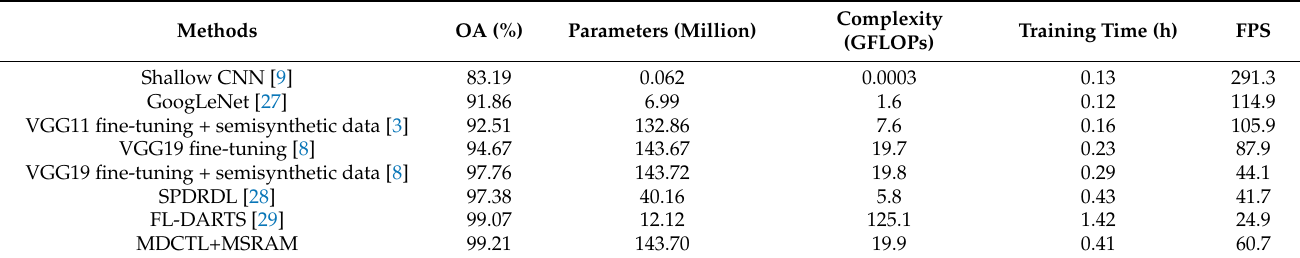
Table 2. Comparison of methods for the classification of SSS images.